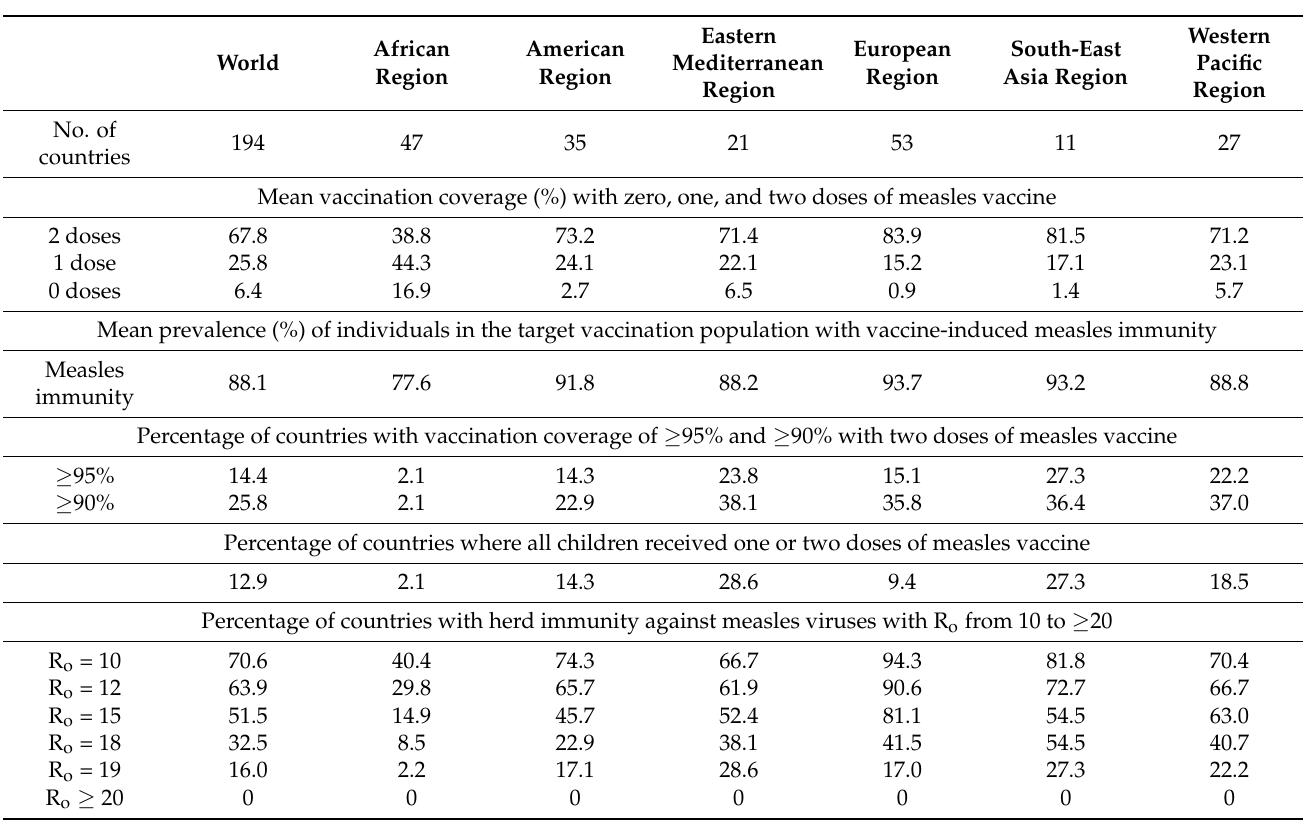
Table 4. Mean vaccination coverage with zero, one, and two doses of measles vaccines, mean prevalence of individuals in the target vaccination population with vaccine-induced measles protection, percentage of countries with anti-measles herd immunity established in the target population vaccination, and percentage of countries with other measles vaccination indicators in regions of the World Health Organization (WHO) in 2019. Western Eastern European South-East African American Pacific Mediterranean World Region Asia Region Region Region Region Region No. of 194 47 35 21 53 11 27 countries